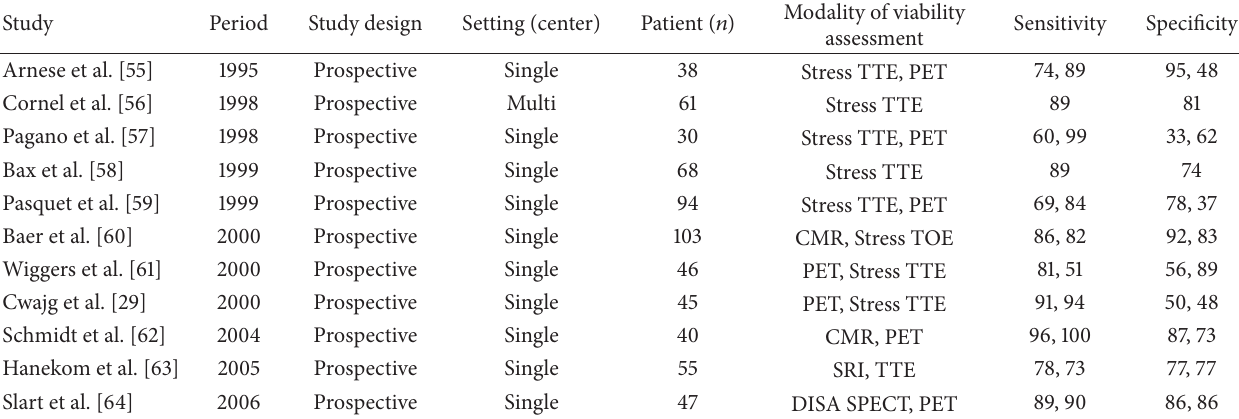
Table 1: Summary of studies evaluating improvement in segmental myocardial function with